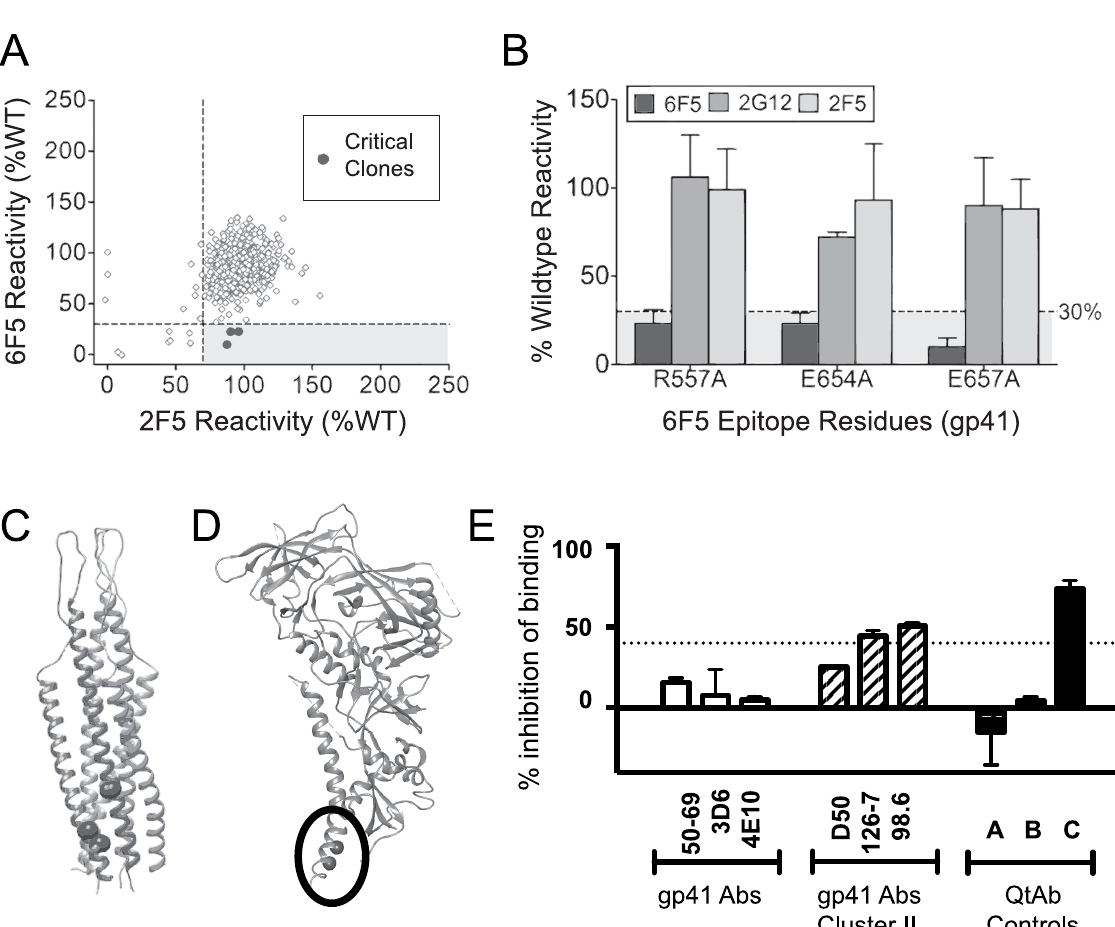
Fig 4. Identification of critical binding residues in the epitope for QtAb 6F5 by shotgun mutagenesis epitope mapping. (A) Binding relative to wild-type HIV gp160 reactivity is plotted for each mutant for the test QtAb 6F5, relative to the control mAb (2F5). Clones with reactivity < 35% for the test mAb but with > 70% reactivity for the control mAb were identified as critical for test mAb binding. (B) Alanine mutation of three individual residues significantly reduced 6F5 binding (dark grey bars), but did not impair binding of control Abs (2G12 or 2F5, shown in light grey or mid grey). Bars represent the mean and range of two replicates. (C) Structural visualization of the critical residues required for 6F5 binding, which compose the Ab epitope. Critical residues are